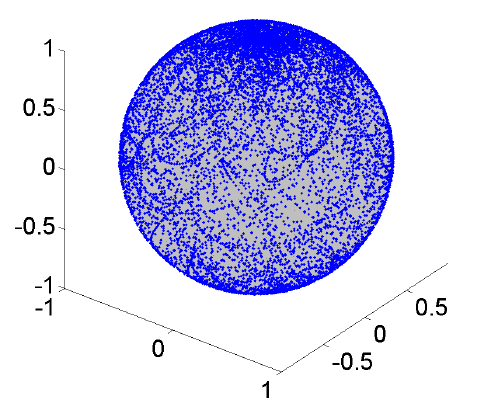
Figure 7. Random walk path distribution on sphere; conventional RPM control schemes lead to concentrations at the poles (low unifomity F* = 188.4).